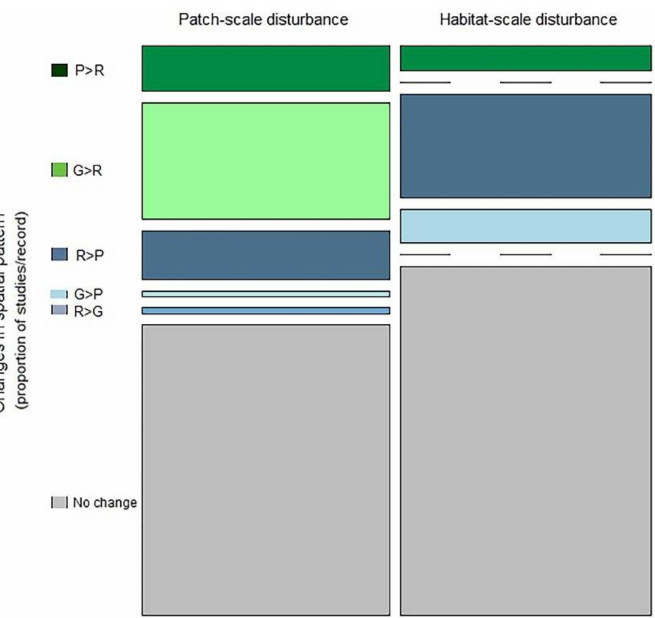
Figure 5. Mosaic plots of the relative frequency of disturbance-driven changes in the categorical spatial patterns of biodiversity for different scales of disturbance. Bar widths are proportional to the number of studies. The height of each bar segment corresponds the relative frequency of certain type of pattern-change among studies for that scale of disturbance. P > R indicates a shift from patchy to random pattern, G > R indicates a shift from gradient to random, R > P indicates a shift from random to patchy, G > P indicates a shift from gradient to patchy, R > G indicates a shift from random to gradient